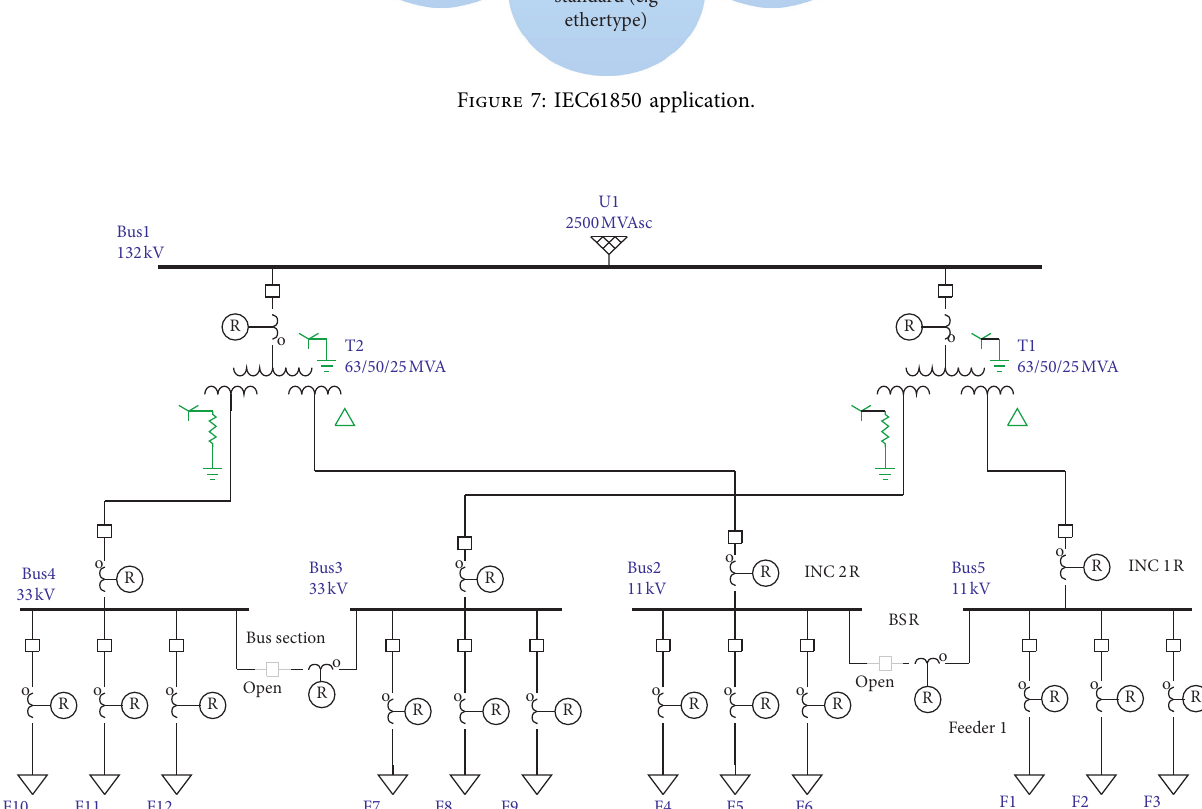
Figure 8: The study system, two transformers of 132/33/11 kV